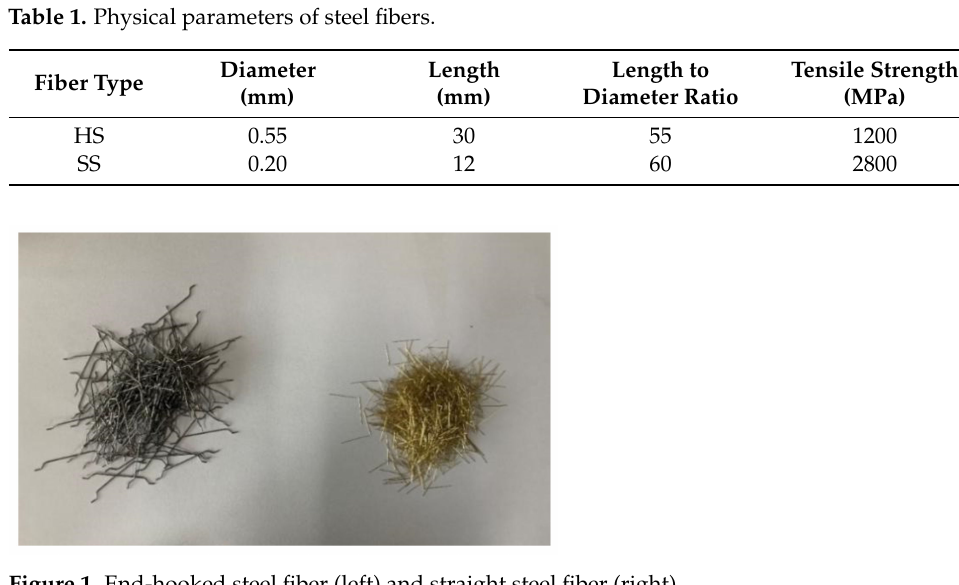
Figure 1. End-hooked steel fiber (left) and straight steel fiber